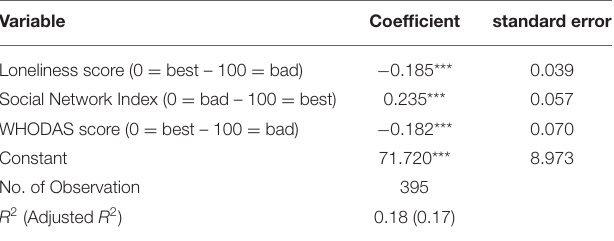
TABLE 3 | Final regression model considering Quality of Life score as dependent variable, measured through the WHOQOL-AGE instrument, adjusted for age and gender.